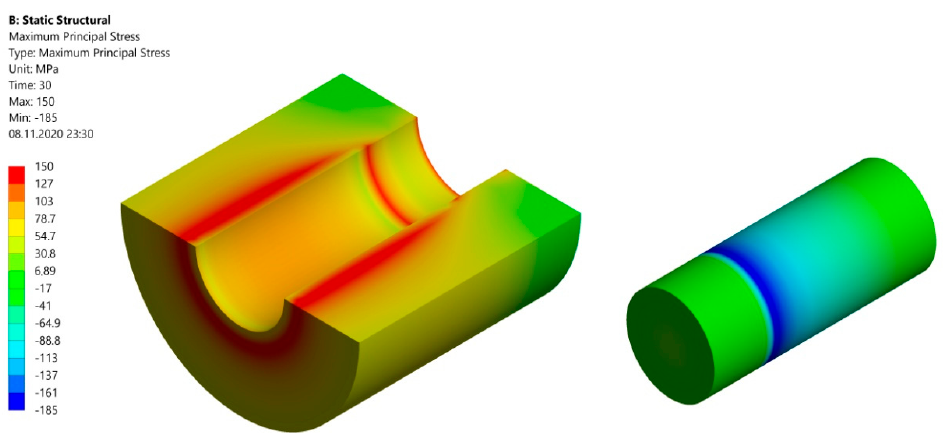
Figure 6. The contour of principal stresses in the hub and the shaft.